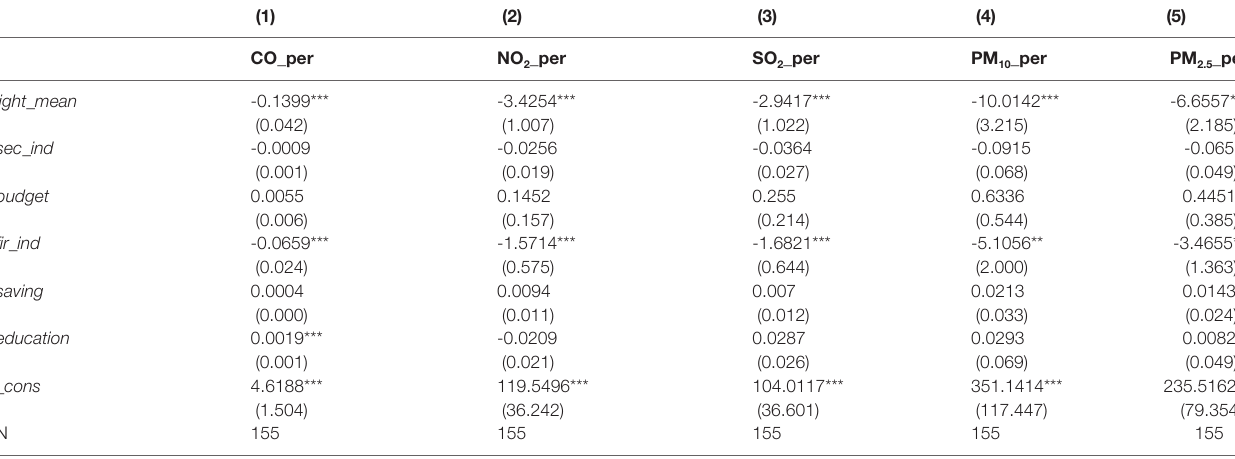
TABLE 6 | The impact of economic development on air pollutants intensity with control variables.